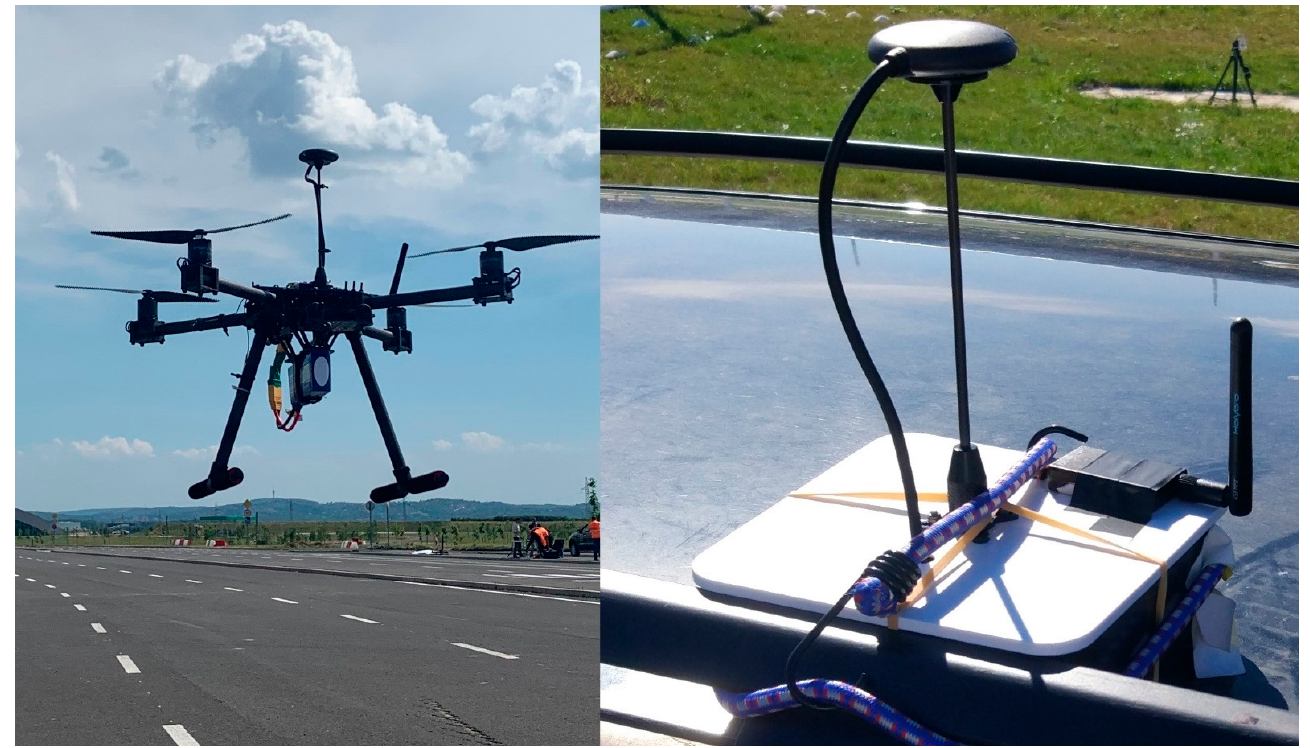
Figure 4. PX4-based real hardware: X500 ( left ) “PX4 in a box” ( right ).